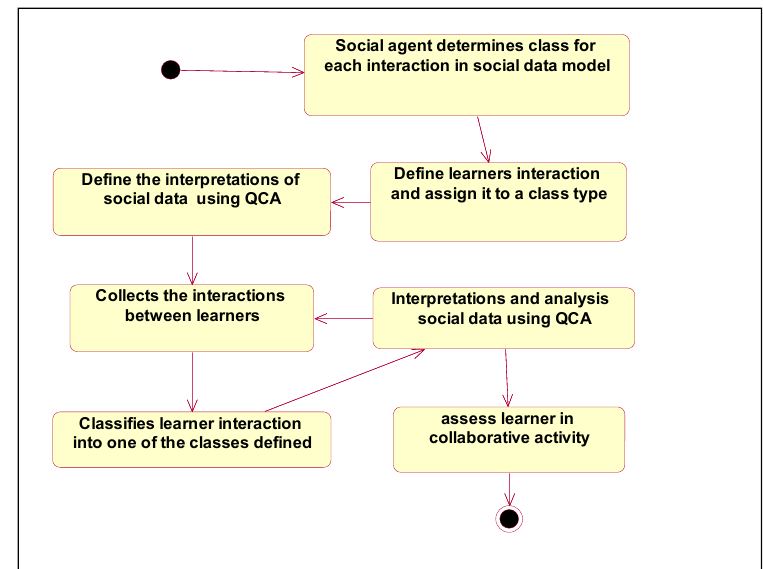
Figure 7. The social agent workflow.